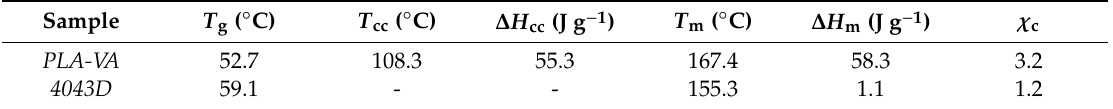
Table 4. DSC data of 4043D and PLA-VA.